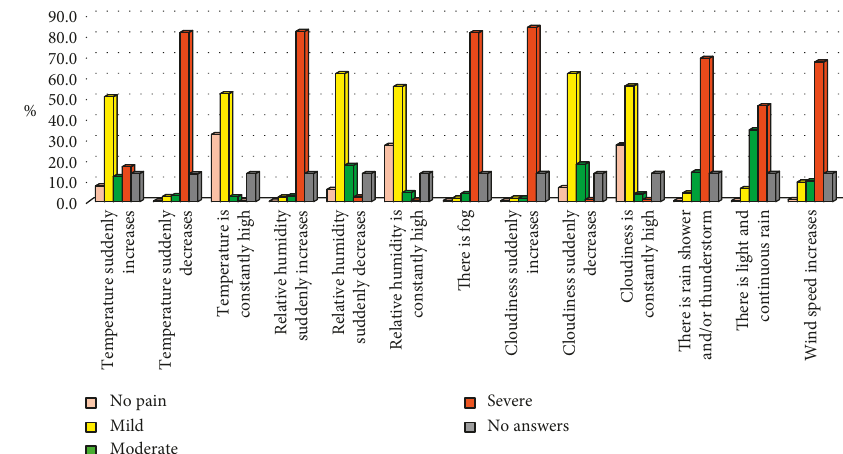
Figure 4: Fluctuations in pain intensity during sudden changes in WeCos